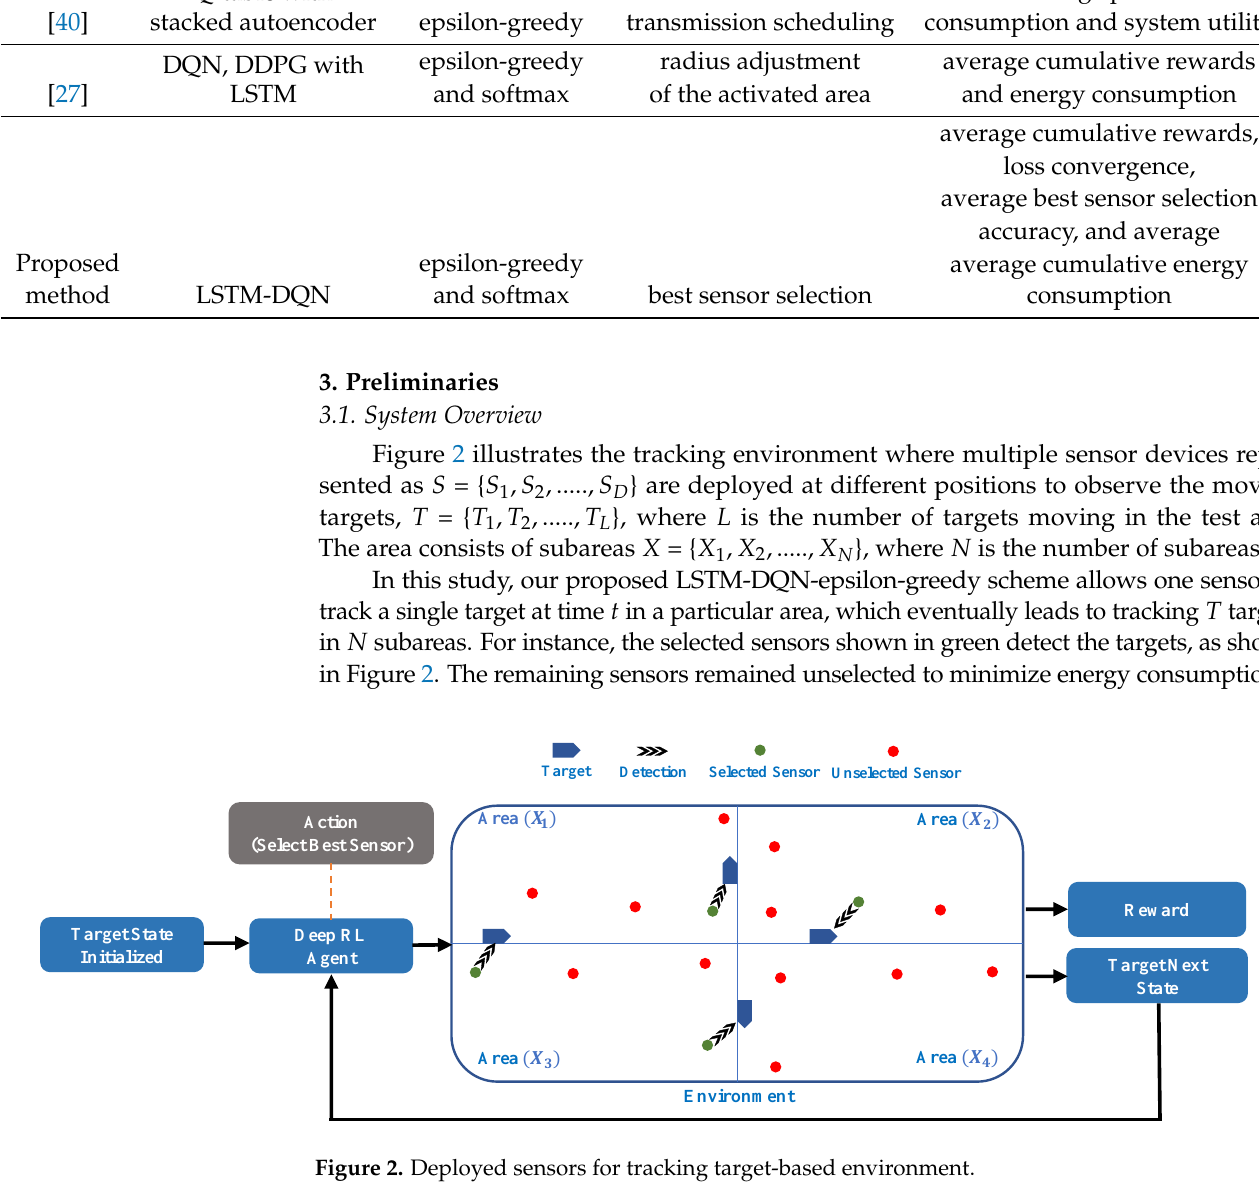
Figure 2. Deployed sensors for tracking target-based